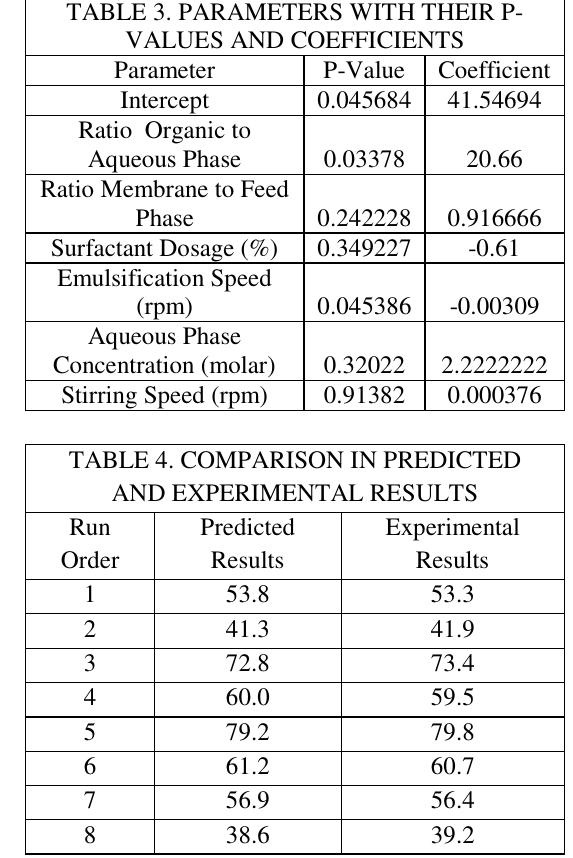
Fig. 3 represents a graph illustrating the predicted and experimental values plotted on it. The values are reasonably distributed in the region of the regression line. The value of correlation constant R 2 was calculated as 0.997 indicating the excellence of fit and validation of the